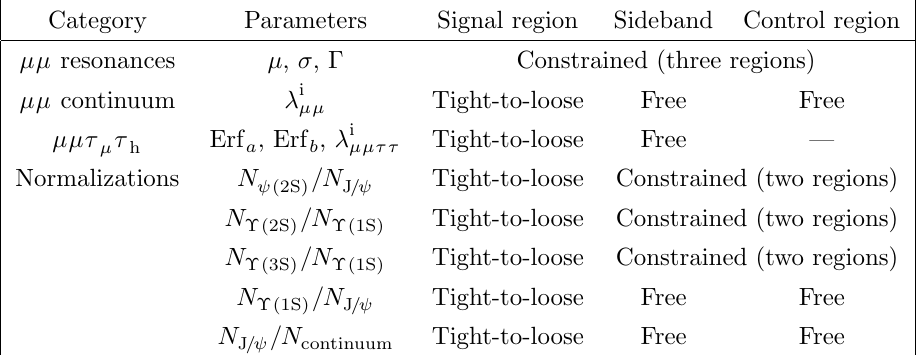
Table 1 . Background model parameters and their relations among the three (cid:12)t regions in the analysis. The (cid:22)(cid:22) background model includes the (cid:12)ve meson resonances modeled using a Voigt function over an exponential continuum. The 4-body background model includes an error function multiplied with the sum of two exponential distributions. Three types of (cid:12)t region relations are used: (a) constrained, in which the parameters are the same in the indicated regions, (b) free, in which the parameter is not related to those in any other region, and (c) related via the (cid:28) tight-to-loose ratio, in which the indicated parameter in the signal region is constrained to the corresponding parameter in the sideband via a linear